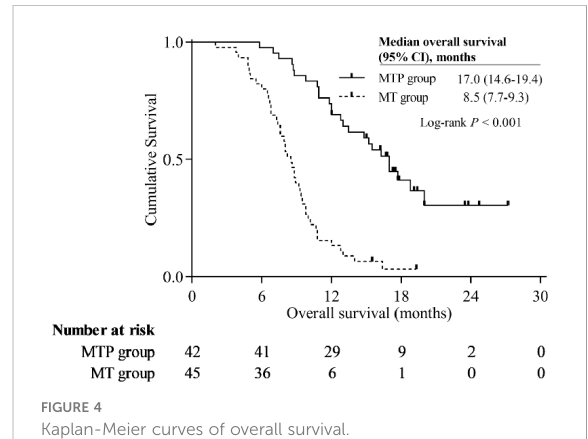
FIGURE 4 Kaplan-Meier curves of overall